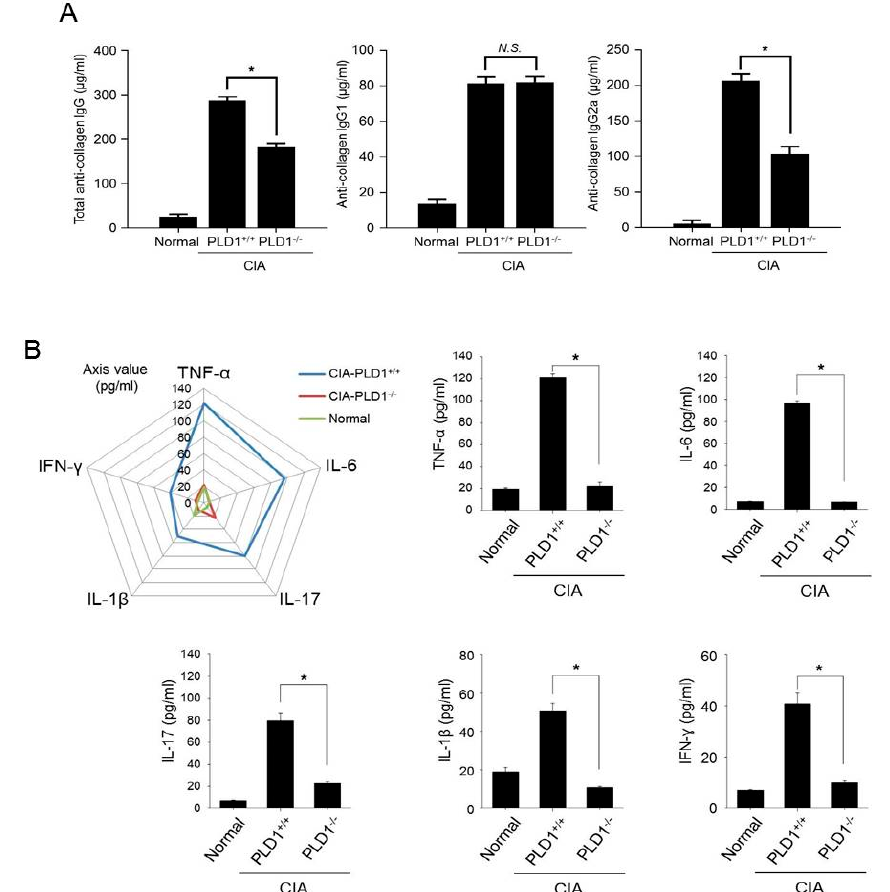
Figure 2. PLD1 deficiency suppresses the collagen type II-specific humoral response and the production of proinflammatory cytokines in collagen-induced arthritis (CIA) mice. ( A ) The amount of anti-collagen total IgG, IgG1, and IgG2a antibodies was measured by ELISA in the serum from the indicated mice at day 42. ( B ) Measurement of proinflammatory cytokines in the serum of the indicated mice at day 42 as analyzed by ELISA. n = 15 per group. * p < 0.05, N.S., non-significant. Results are shown as mean ± standard error of the mean (SEM).